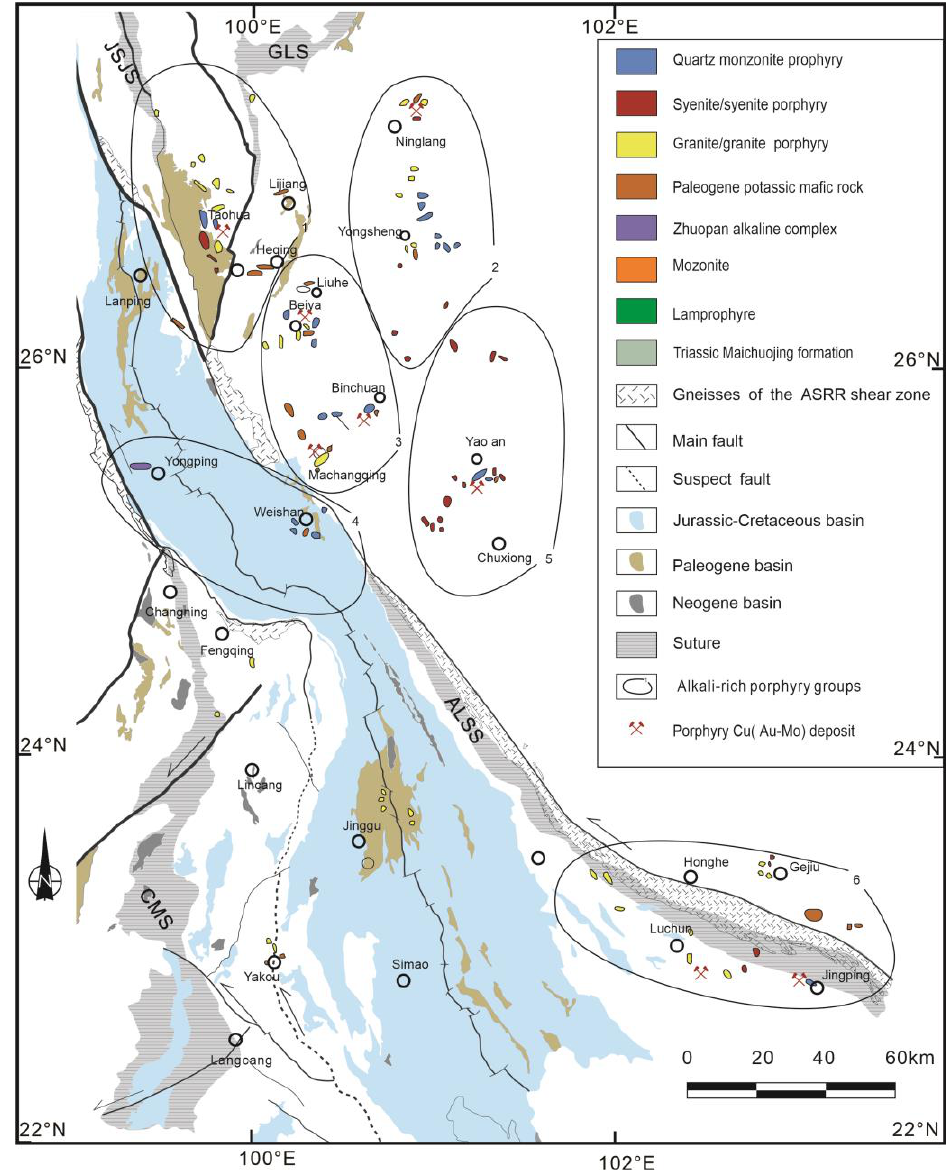
Figure 6. Cenozoic alkali-rich porphyry showing distribution in western Yunnan. Adapted with permission from Ref. [152]). 2020, Wiley Online Li b rary . permission from Ref. [152]. Copyright 2020 Wiley Online